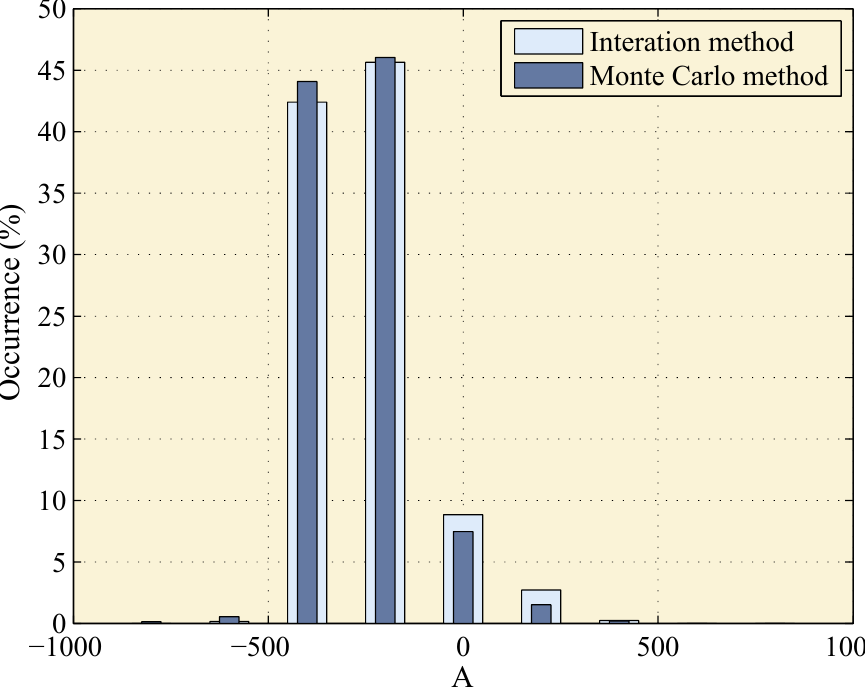
Figure 20. Differences between original ampacity calculations and effective ampacity through both